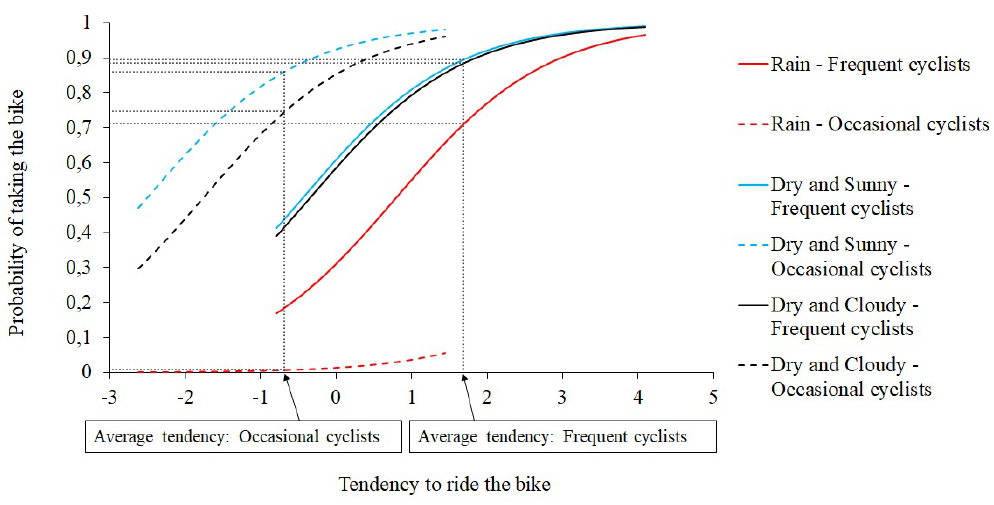
Figure 6. Probability of taking the bike in different weather conditions.